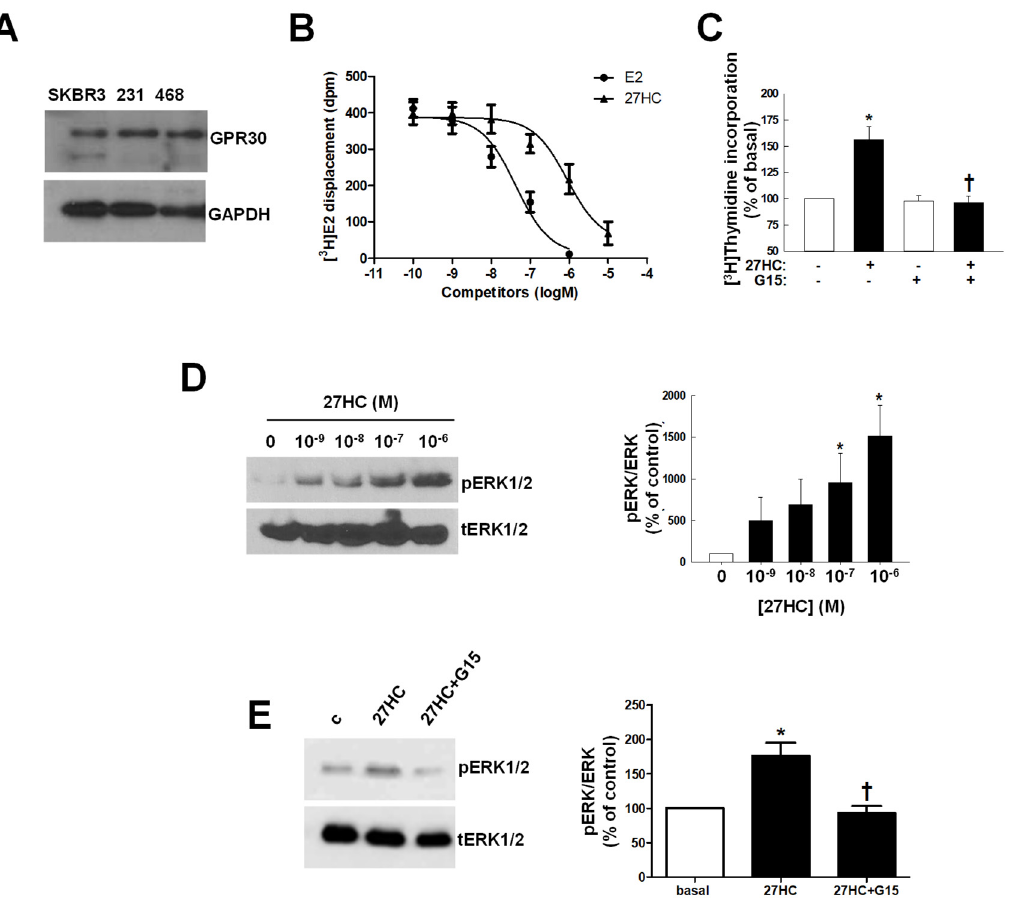
Figure 2. 27HC binds to GPR30 and activates ERK1/2. ( A ). GPR30 expression was evaluated in whole-cell lysates from SKBR3, MDA-MB-231 (231) and MDA-MB-468 (468) cells. ( B ) Estradiol (E2) and 27HC competitive binding to GPR30 was evaluated using plasma membranes isolated from GPR30-expressing HEK293 cells. [ 3 H]E2 displacement is shown in the presence of increasing concentrations of E2 or 27HC. Values are mean ± SEM, n = 3. ( C ). Cells were treated for 48 h with 27HC 10 − 6 M with or without G15 (10 − 6 M), * p < 0.05 vs. basal (untreated cells); † p < 0.05 vs. 27HC. ( D , E ) Western blot analysis was performed to detect posphorylated ERK1/2 (pERK1/2) or total ERK1/2 (tERK1/2) on whole-cell lysates from MDA-MB-231 cells treated for 15 min with 0 to 10 − 6 M 27HC ( D ) or with 27HC 10 − 6 M and G15 10 − 6 M alone or in combination ( E ). Left panels display representative Western blots, and right panels provide summary data. Values are mean ± SEM, n = 3. ERK1/2 are part of the GPR30 downstream pathway [37]. In response to 27HC we observed a dose-dependent increase in ERK1/2 phosphorylation (Figures 2D and S3C,D),